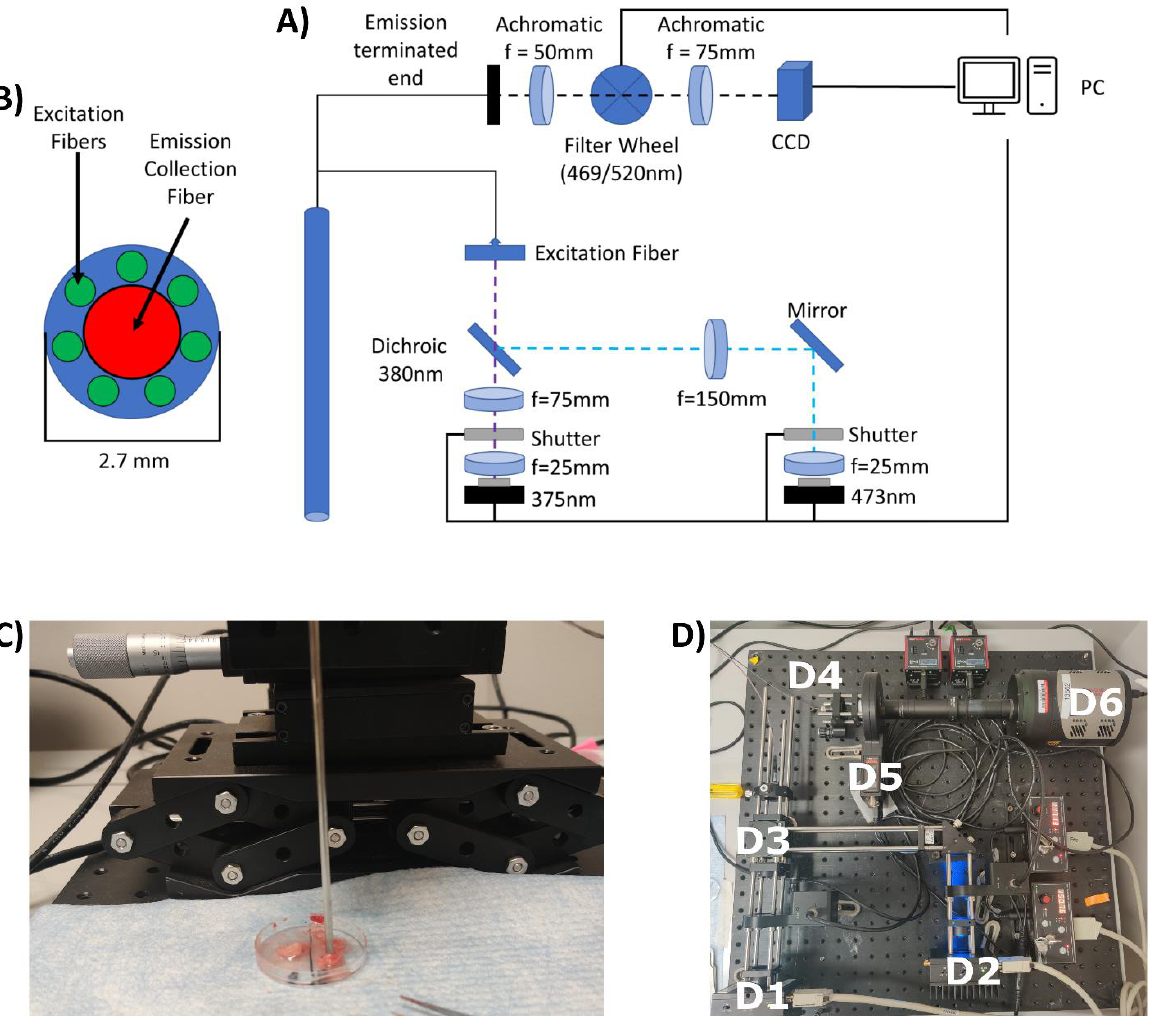
Figure 1. Endoscope schematics. ( A ) schematic of the developed endoscope, ( B ) a zoomed-in version of the endoscope tip, ( C ) a picture of the endoscope shaft, and ( D ) an image of the inside of the internal components of the endoscope system with the components being denoted by the following labels: ( D1 ) 375 nm laser, ( D2 ) 473 nm laser, ( D3 ) excitation fiber bundle, ( D4 ) terminal end of the imaging fiber bundle, ( D5 ) filter wheel, and ( D6 ) CCD.